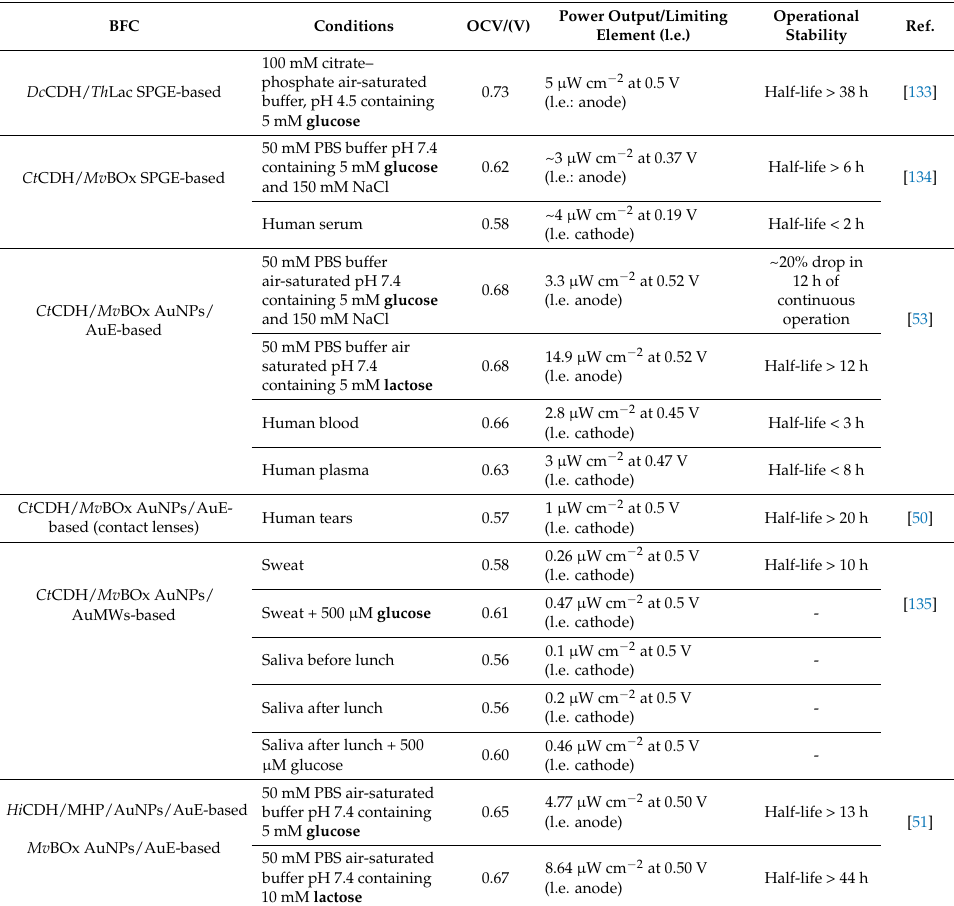
Table 3. DET-based lactose/glucose and glucose/oxygen enzymatic fuel cells (EFCs) are compared based on some of the operational parameters like operating conditions, open-circuit voltage (OCV), power output and operational stability. Abbreviations: AuE gold electrode, AuMWs gold microwires electrode, AuNPs gold nanoparticles, Ct CDH Corynascus thermophilus CDH, Dc CDH Dichomera saubinetii CDH, Hi CDH Humicola insolens CDH, MHP N-(6-mercapto)hexylpyridinium, Mv BOx Myrothecium verrucaria bilirubin oxidase, SPGE